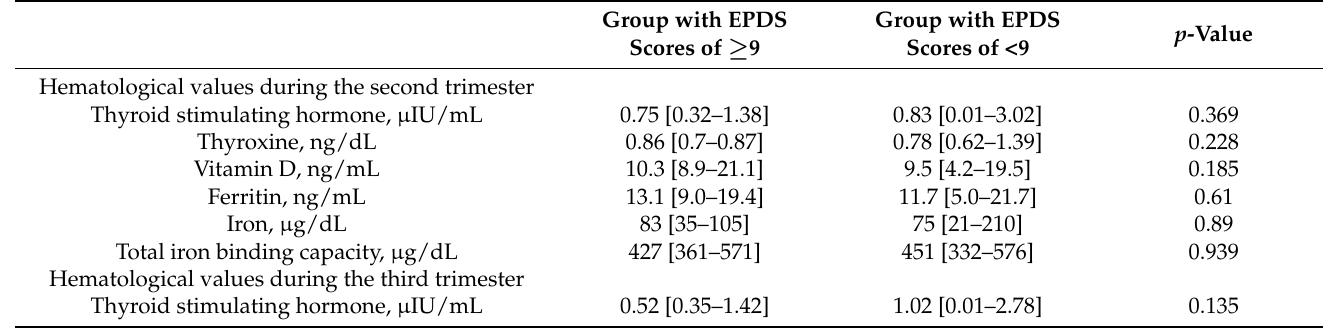
Table 4. Association between EPDS scores at 1 month postpartum and hematological